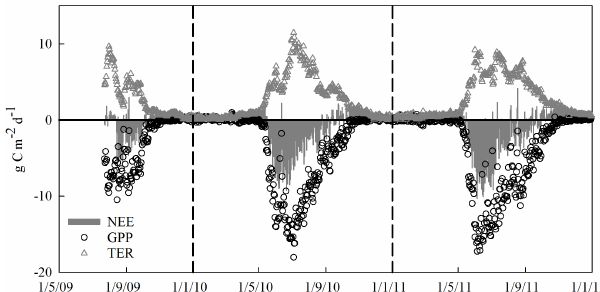
Figure 5. The components of daily CO 2 exchange over the mea- surement period. Daily sum of net ecosystem CO 2 exchange (NEE, grey bars), gross primary production (GPP, open black circles) and total ecosystem respiration (TER, open grey triangles) as gCm − 2 d − 1 . Horizontal solid black lines show the zero level and vertical dashed black lines mark beginning of the year. Figure 6. Relationship of gross primary production (GPP)